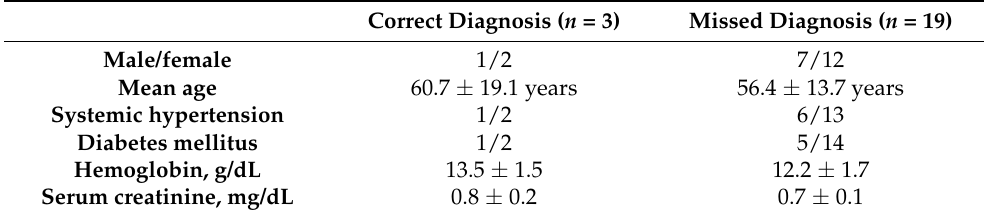
Table 3. Clinical characteristics between the patients with correct diagnosis and those with missed diagnosis of PDA in the group